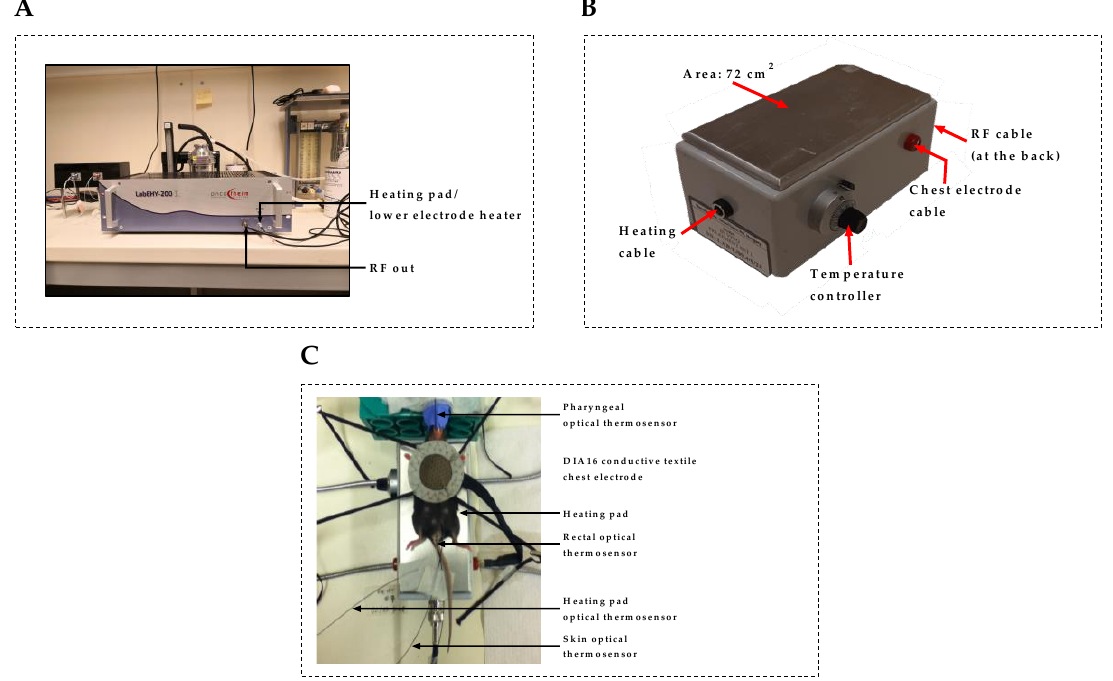
Figure 10. Treatment devices of modulated electrohyperthermia in mice. ( A ) LabEHY-200 treatment device; ( B ) Heating pad/lower electrode; ( C ) Conventional round upper electrode with main application in the treatment of primary solid tumors.